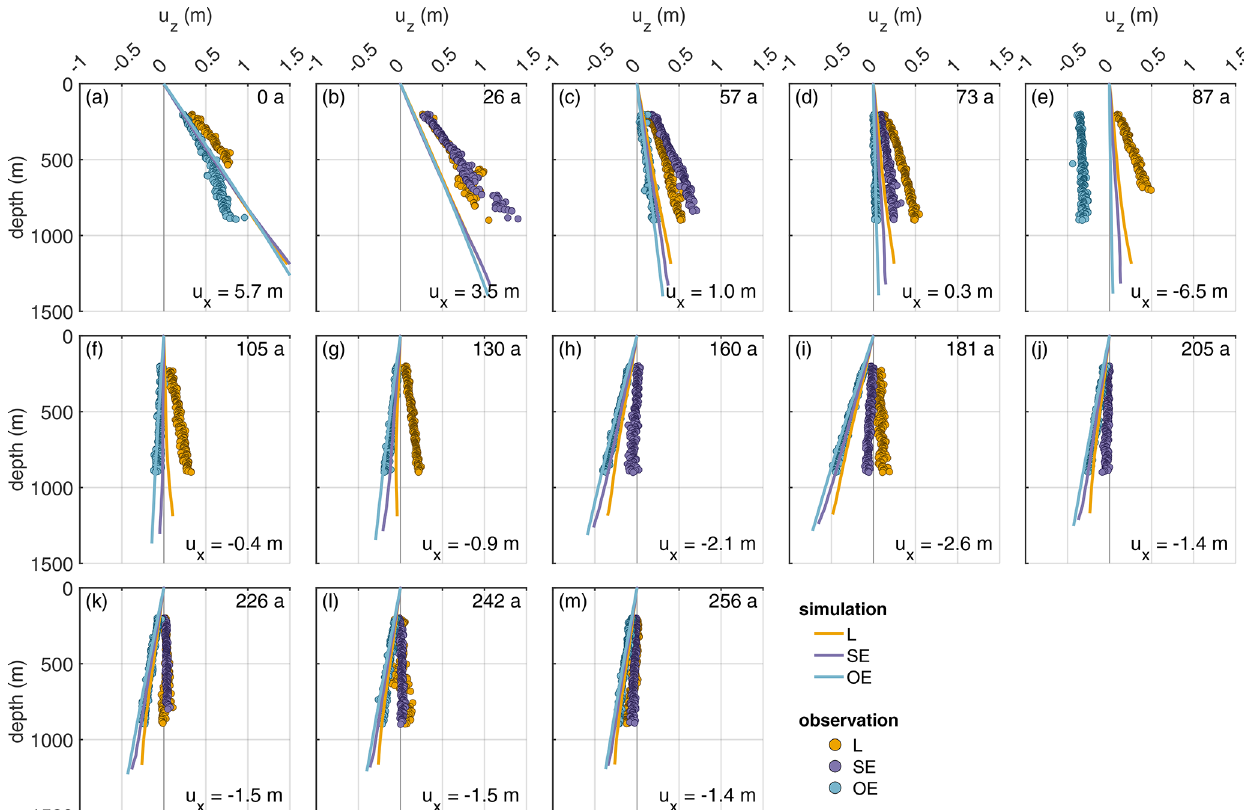
Figure B7. First experiment: comparison of displacements ( u z ) derived from pRES measurements (dots) and from the simulations (lines). The different panels show the displacement for (cid:49)t = 1 year allocated to the year of the model (number in upper right corner). The numbers in the lower right corners give horizontal displacement u x derived from ε zz of the pRES measurements outside the channel (OE), with positive values representing compression and negative values